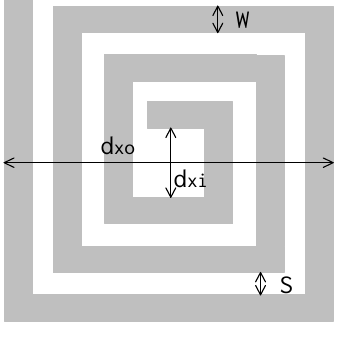
Figure 8. Diagram of the square coil.